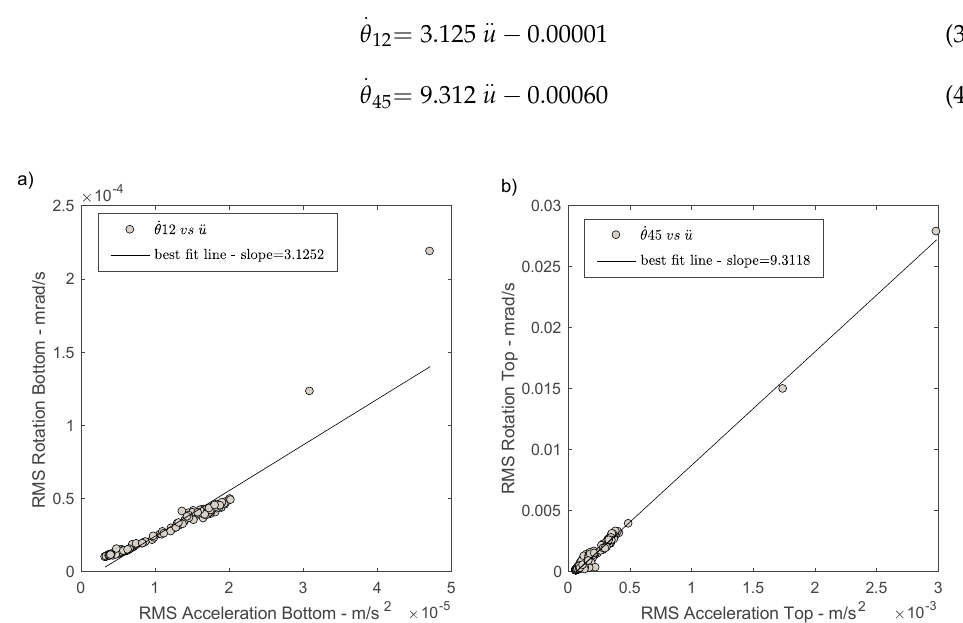
Figure 9. Comparison between translation and array-derived rotation at the bottom ( a ) and at the top ( b ) of the structure.